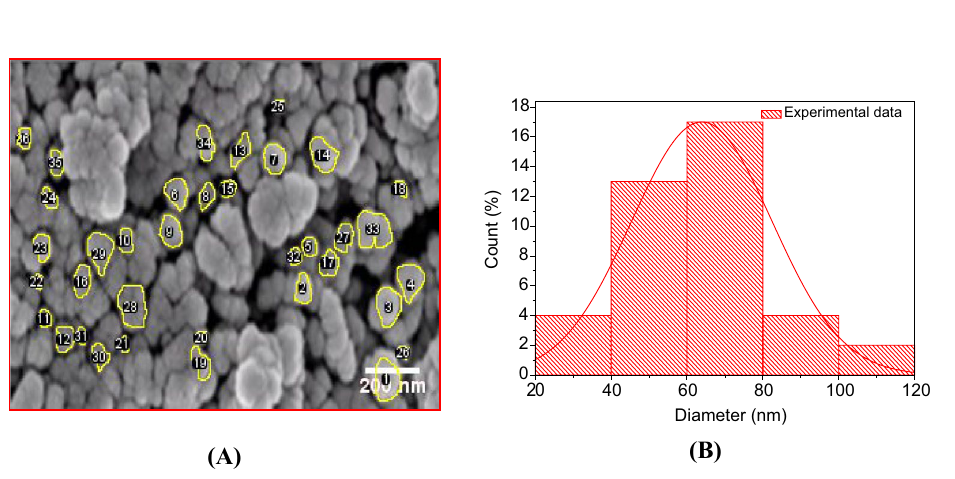
Figure 4. ( A ) SEM image and ( B ) Average particle size distribution (histogram) from SEM image by Image J software of NAFO